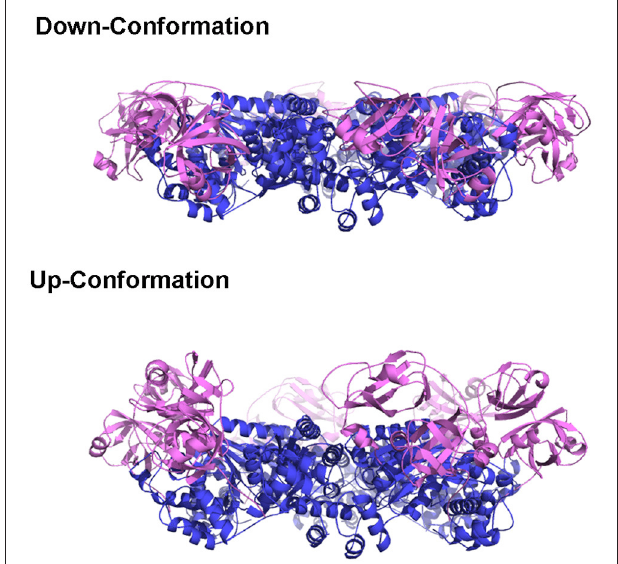
FIGURE 2 | The Up- and Down-conformation of p97 N domain. Ribbon presentation of the structure of the hexameric ND1 p97. The D1 domains are colored in blue and the N domains are in